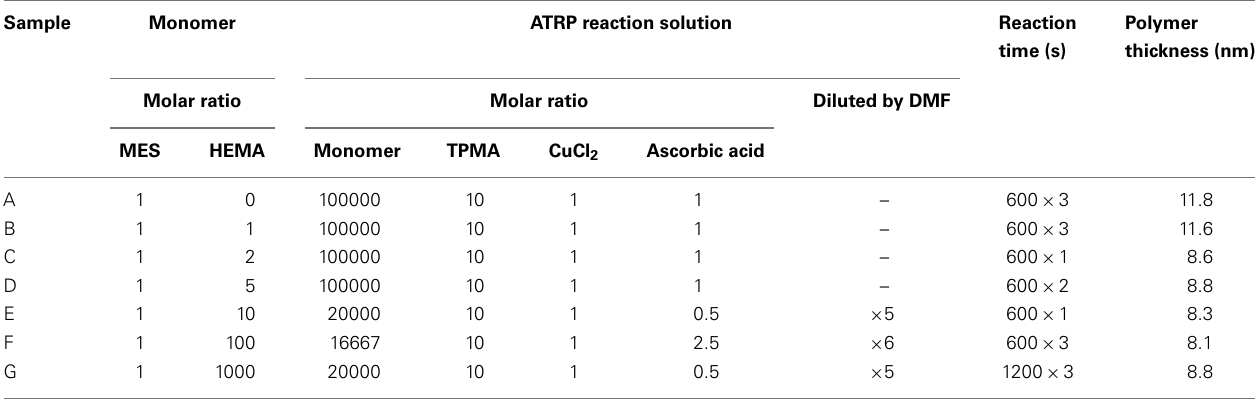
Table 1 |The reaction conditions and the thickness of polymer layer; diluted by DMF: monomer solution inATRP reaction solution was diluted by DMF with some fold volume; reaction time: for example, “600 × 3” means that the polymerization thrice was performed for 600s . Sample